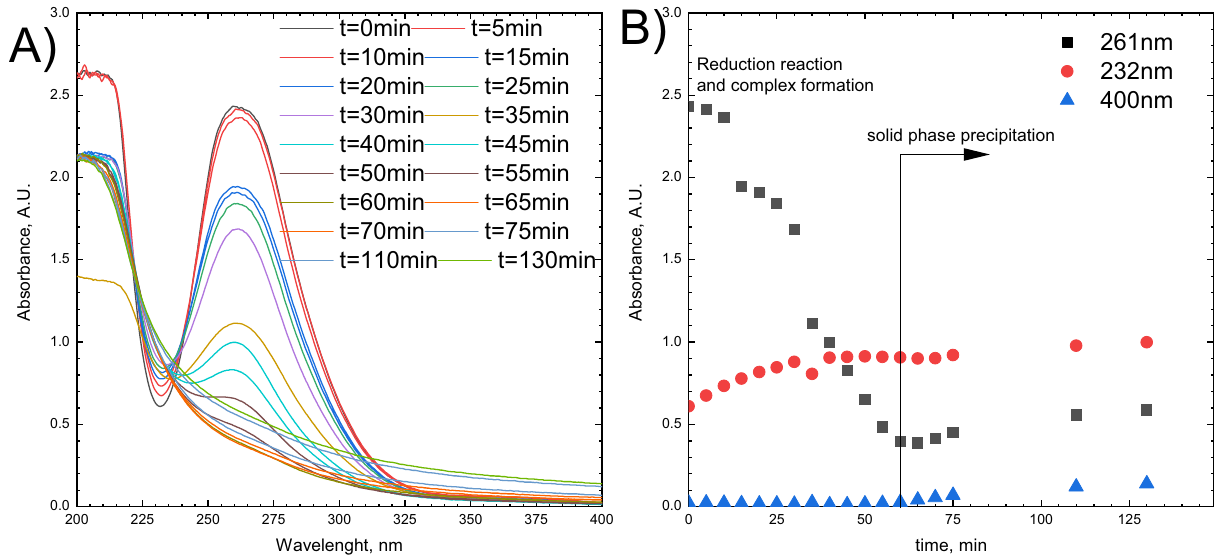
Figure 1. Kinetics of reduction of Pt(IV) chloride complex with TSC in the batch reactor: ( A ) UV–Vis spectra as a function of time; ( B ) kinetic curves. Experimental conditions: [Pt(IV)] = 1 × 10 −4 M, [TSC] = 2 × 10 −3 M, T ≈ 100